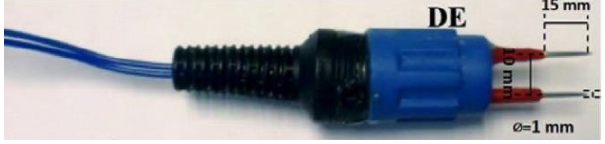
Figure 2. Stainless steel double-needle sensor [33].